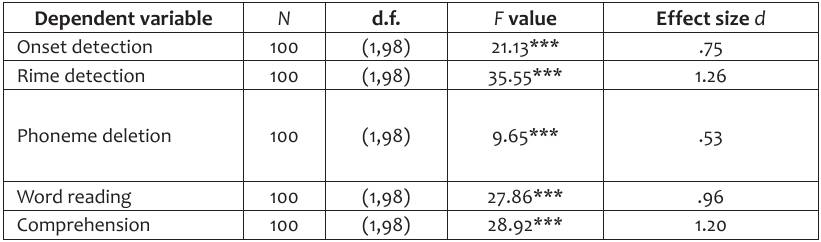
Table 2: MANOVA results comparing EL1 and EL2 learners’ performance on the phonological awareness and reading